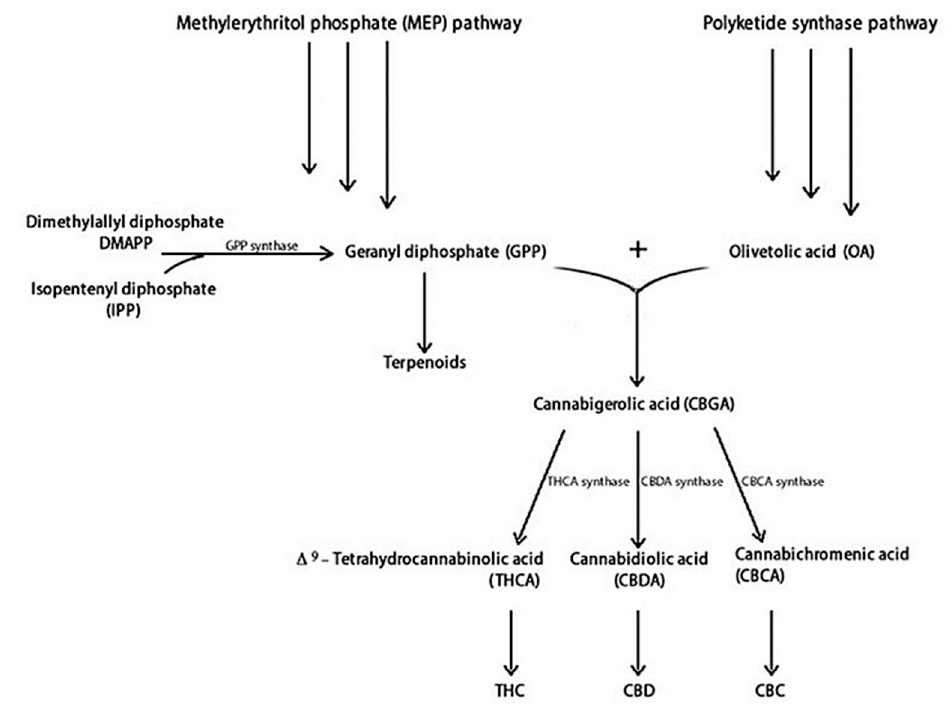
Figure 1. Cannabinoids and terpenoids biosynthesis in C. sativa [38,41].